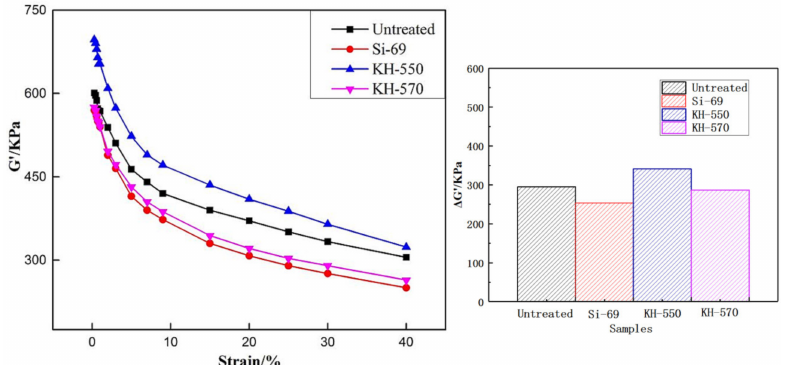
Figure 5. Rubber processing analyzer (RPA) curves of compound with di ff erent silane coupling